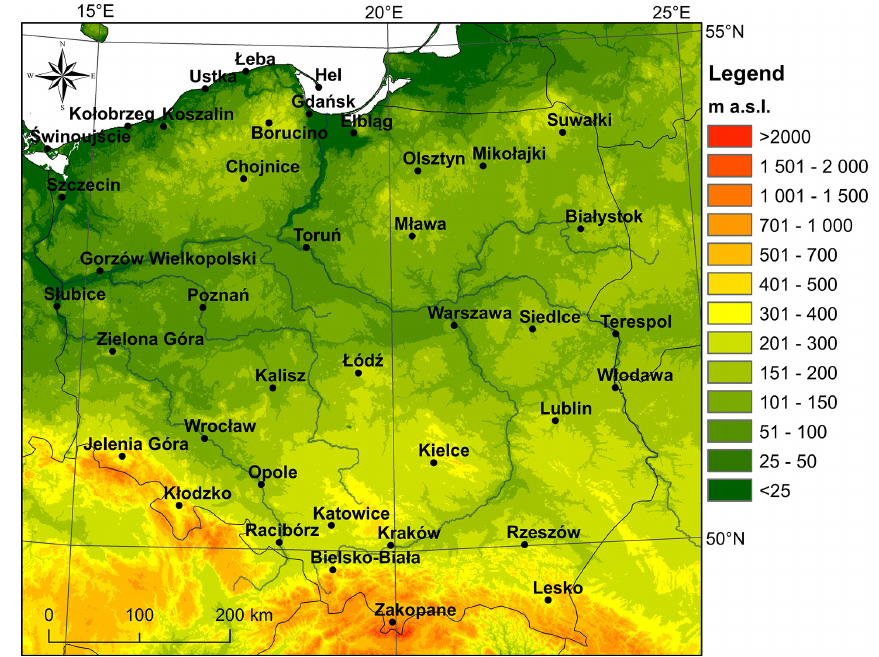
Fig. 1. Location of meteorological